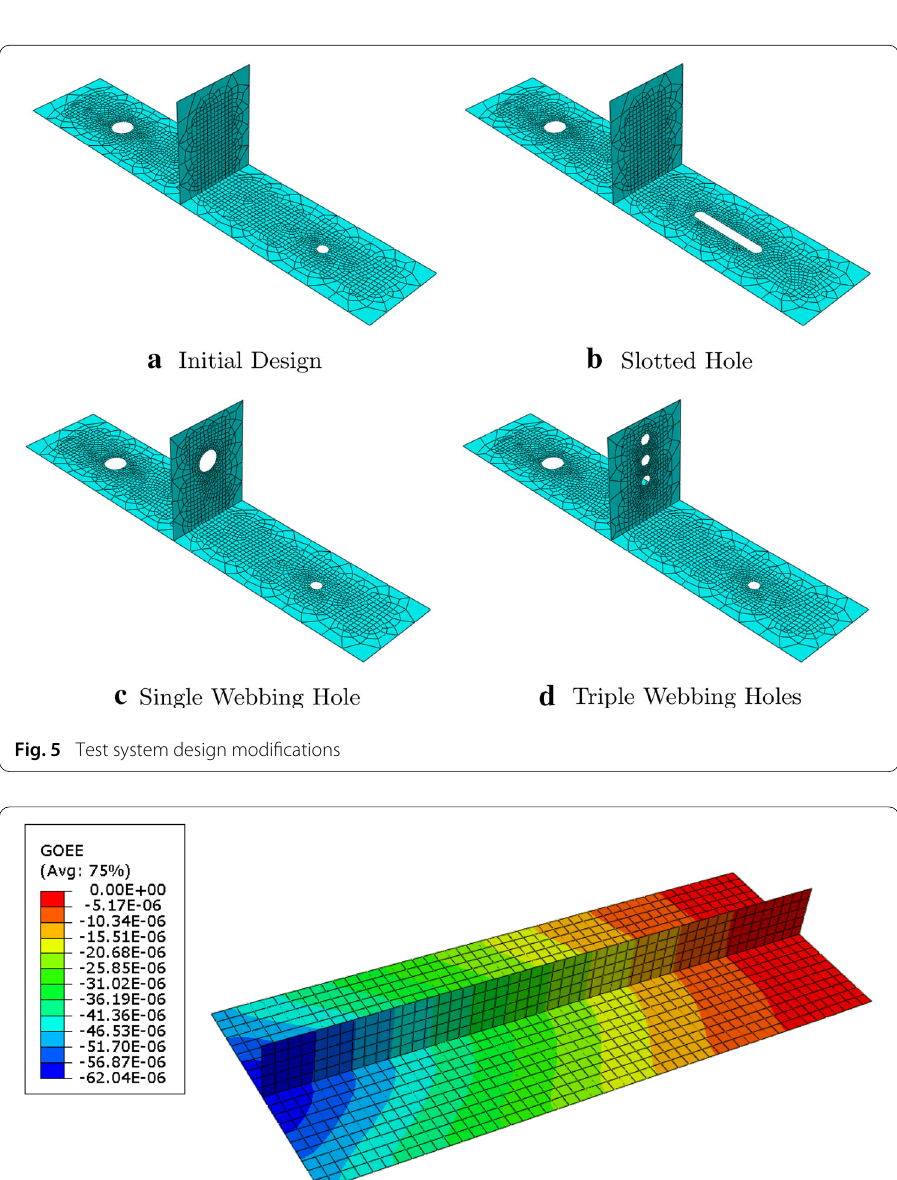
Fig. 6 Global GOEE results in